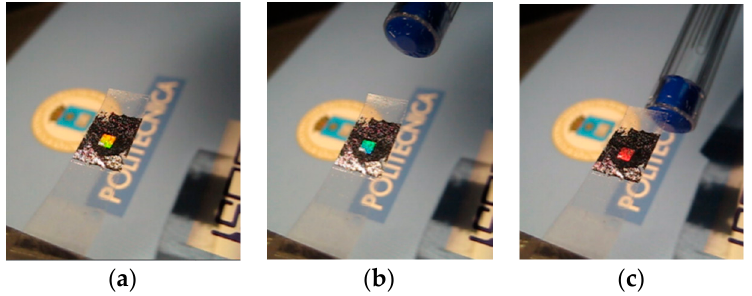
Figure 7. An electrostatic-opto-mechanical sensor [21]. ( a ) A Scotch tape cantilever with an integrated Al diffraction grating. The tape is electrically charged by peeling it off. When a plastic pen is placed close to the charged tape ( b , c ), opposite charges are induced in the pen. Electrostatic forces between the tape and the pen result in bending of the cantilever, which is observed as an iridescent color change of the Al diffraction grating.